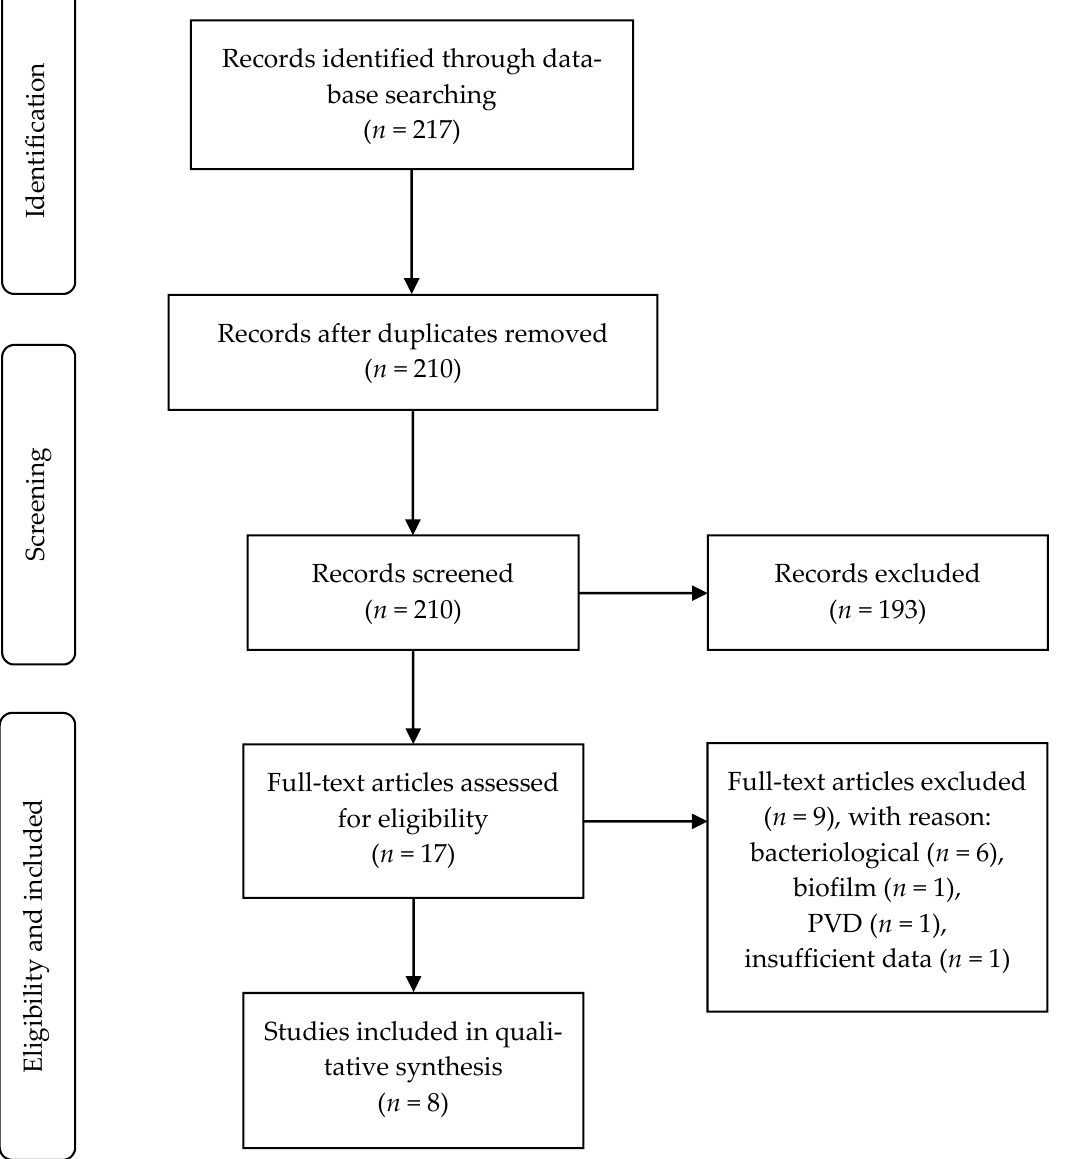
Figure 1. STROBE flow chart. Abbreviation: PVD, peripheral vascular disease.